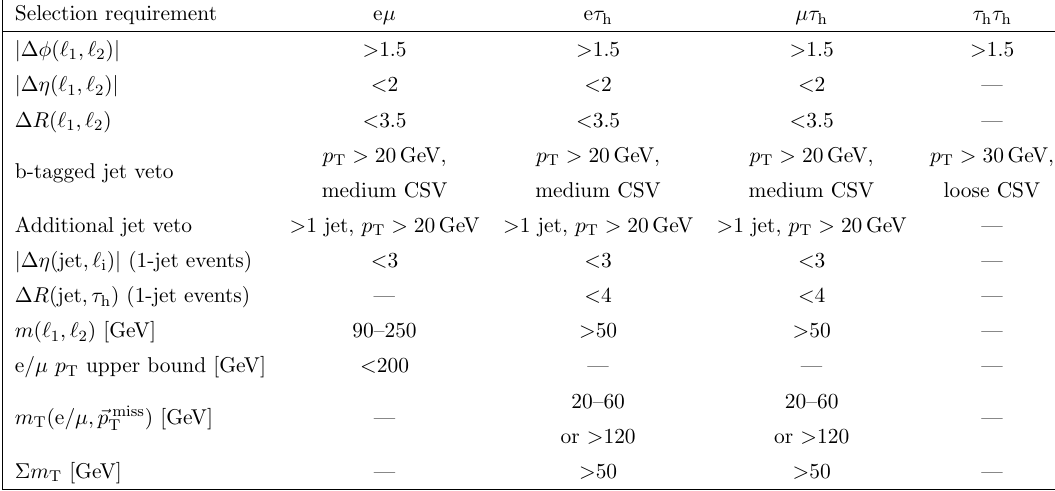
Table 3. Summary of baseline selection requirements in each (cid:12)nal